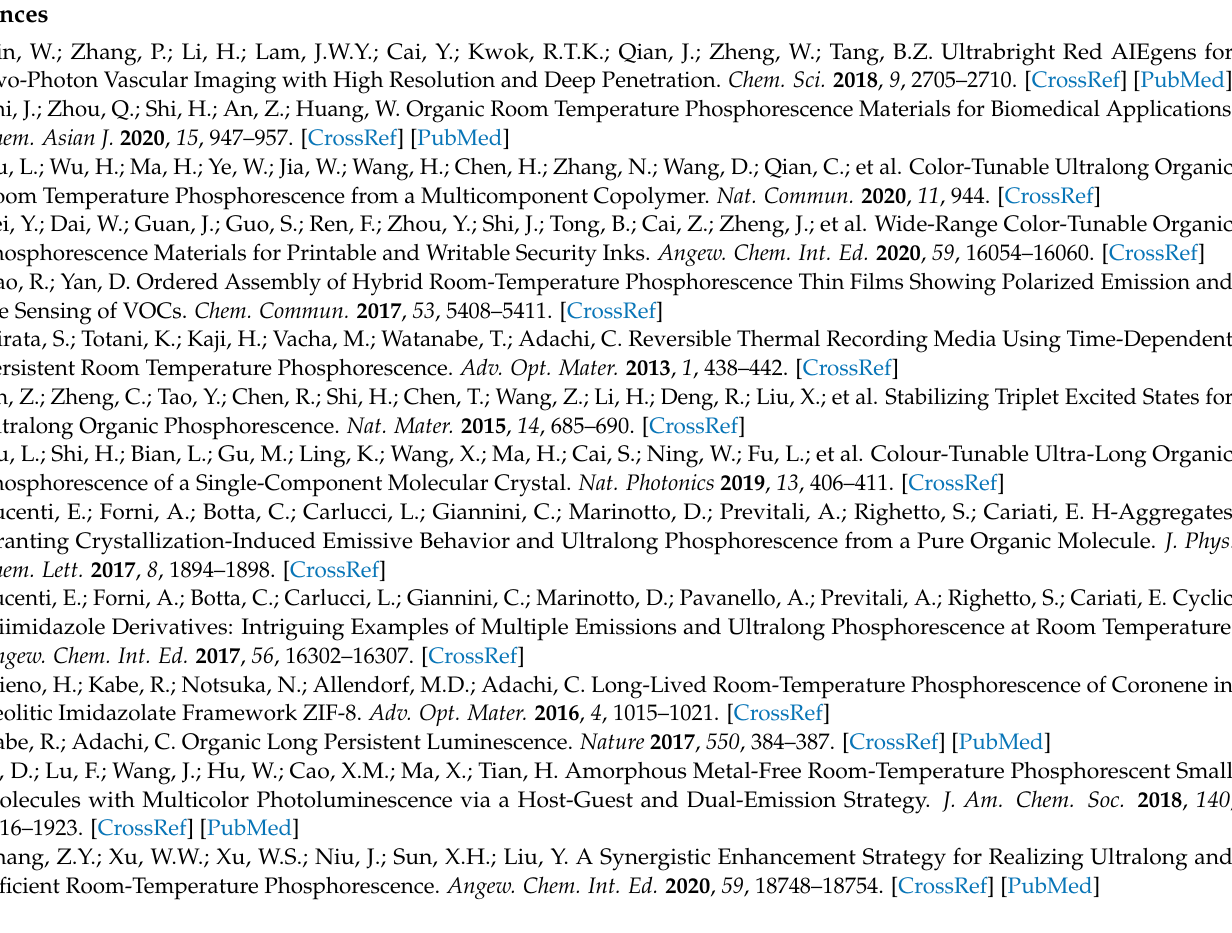
Table S1: crystal data; Figures S5–S30: photophysical data; Table S2–S3: computational